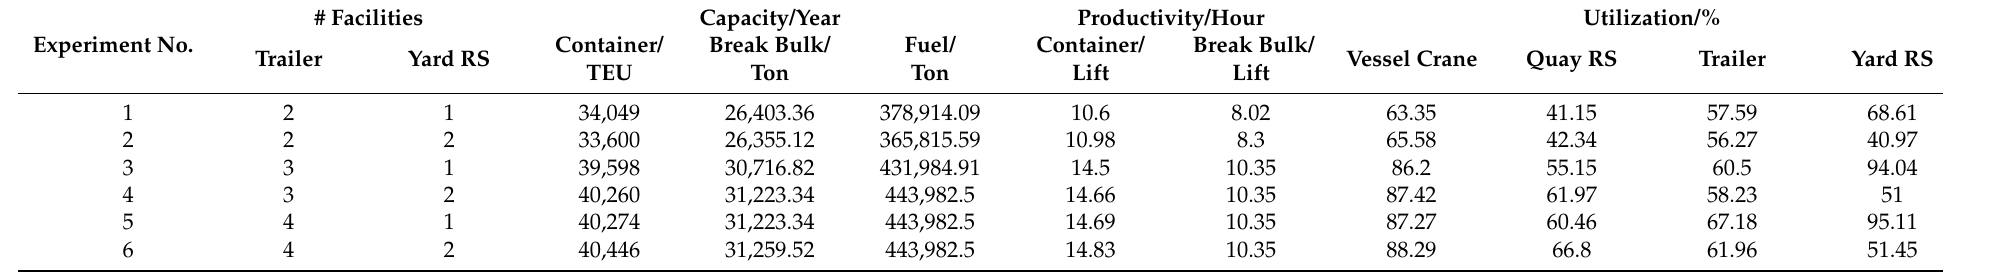
Table A1. Results of all indicators when trailers and quay reach stacker are